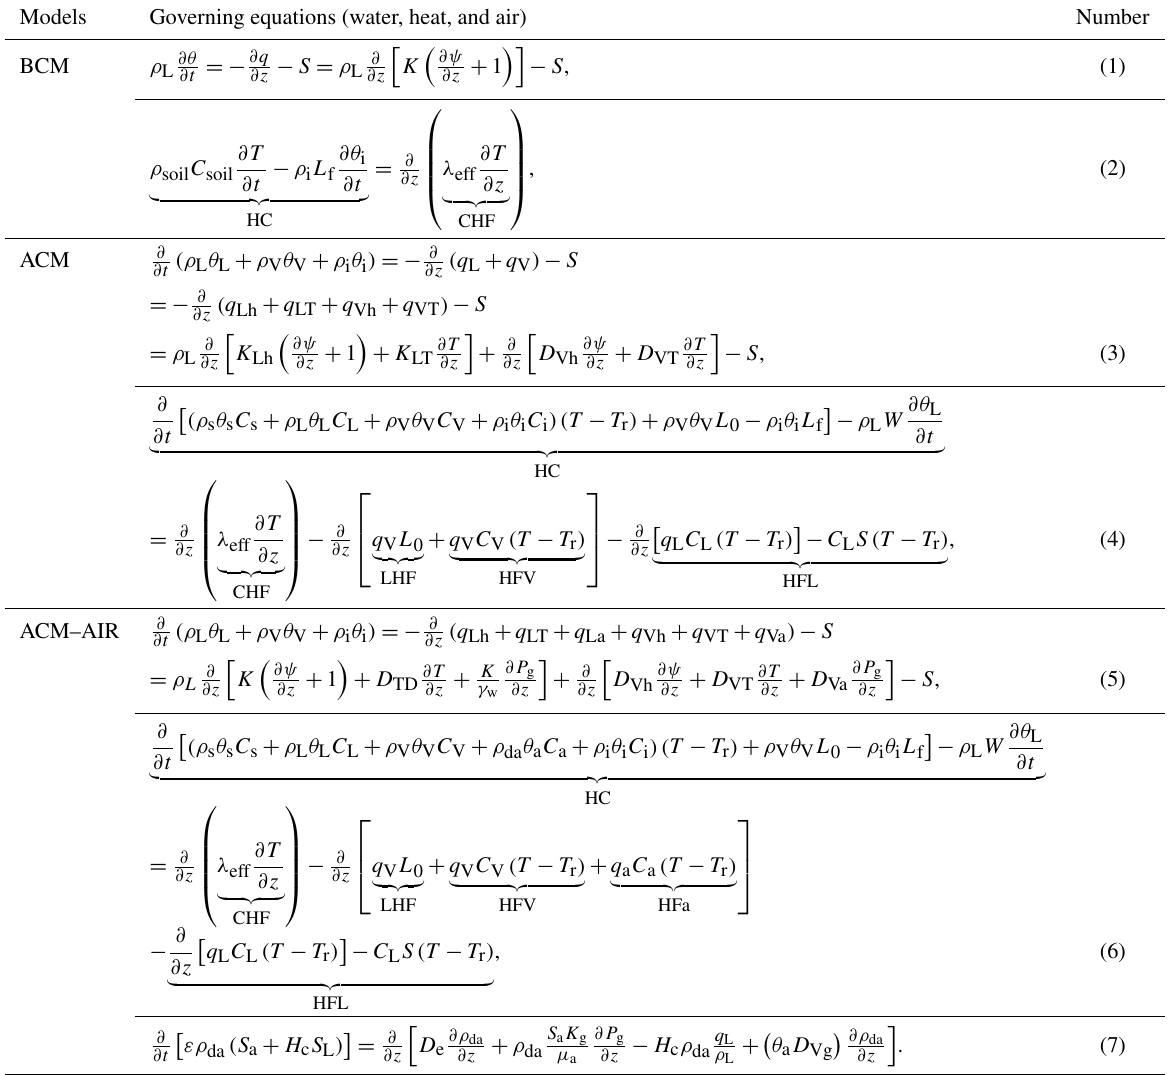
Table 1. Governing equations for different complexities of water and heat coupling physics (see the Appendix for notations). Models Governing equations (water, heat, and air)